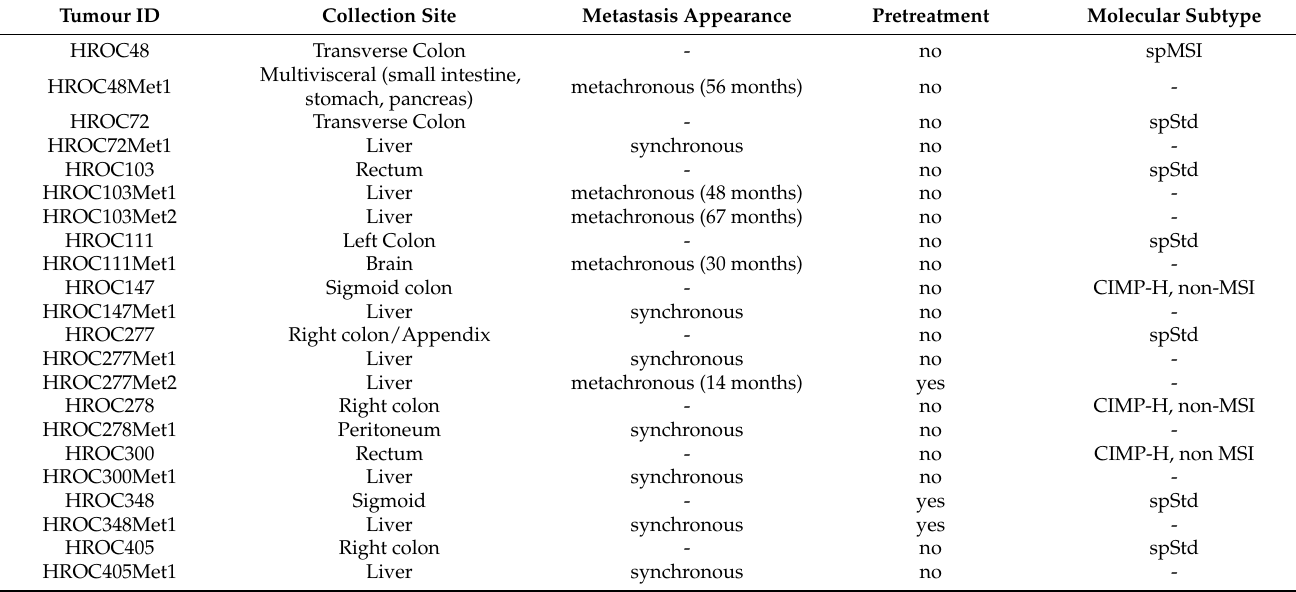
Table 1. Characteristics of tumours and